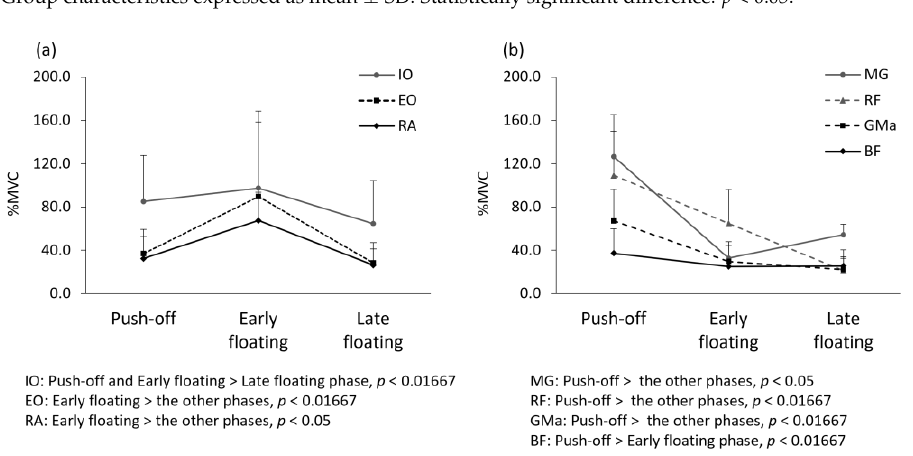
Figure 4. Comparison of muscle activity by the jump header shooting phases in pre-intervention. Mean and standard deviation for the electromyographic activity of ( a ) abdominal muscles and ( b ) lower extremity muscles in pre-intervention. Abbreviations: IO — internal oblique; EO — external oblique; RA — rectus abdominis; MG — gastrocnemius medial head; RF — rectus femoris; GMa — gluteus maxims; BF — biceps femoris; MVC — maximum voluntary contraction.